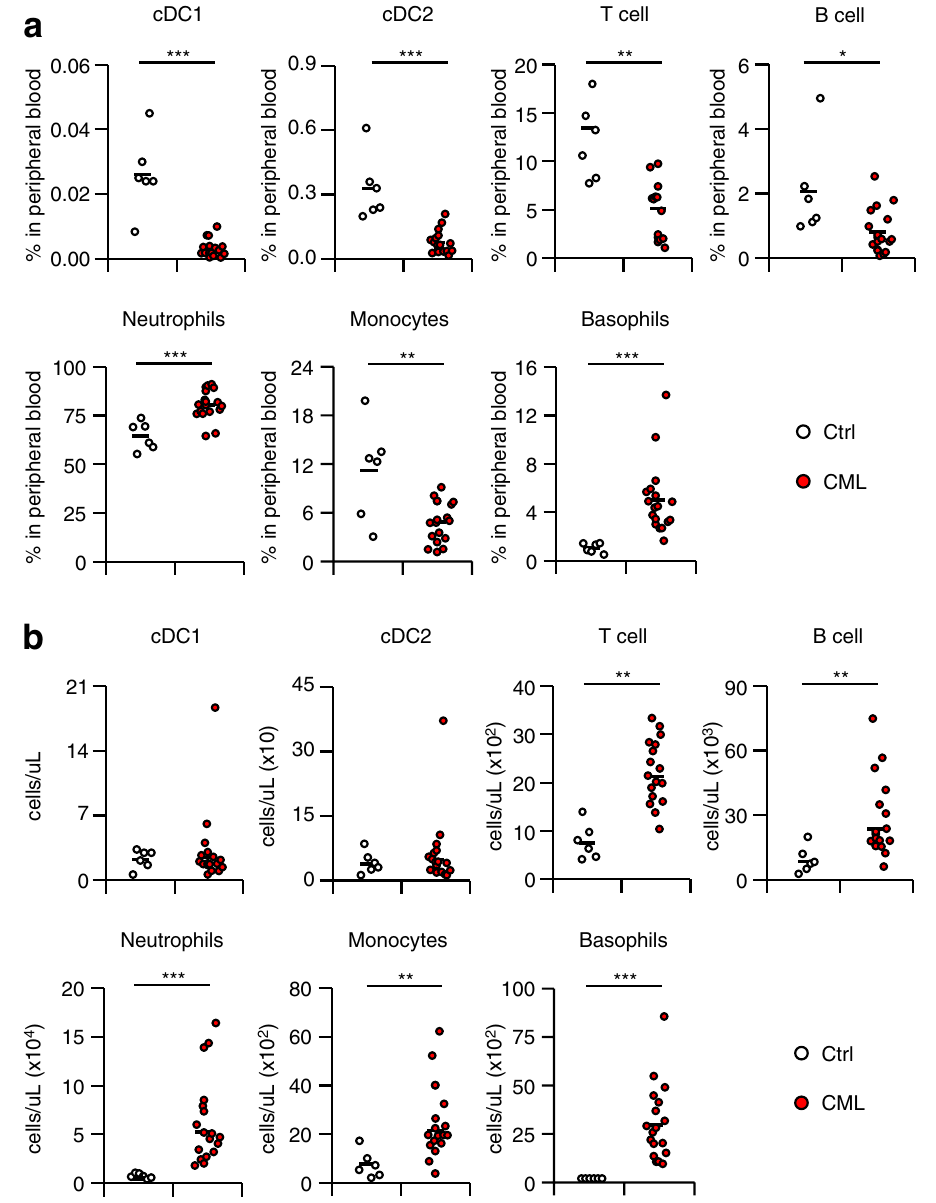
Figure 1. Proportion and absolute number of immune cells in CML patients. ( a ) Proportion of peripheral blood immune cells in CML patients (Healthy controls [Ctrl], n = 6; CML patients [CML], n = 18). ( b ) Absolute number of peripheral blood immune cells in CML patients (Healthy controls [Ctrl], n = 6; CML patients [CML], n = 18). The horizontal lines indicate mean values. * P < 0.05, ** P < 0.01, *** P < 0.001 (Student’s t